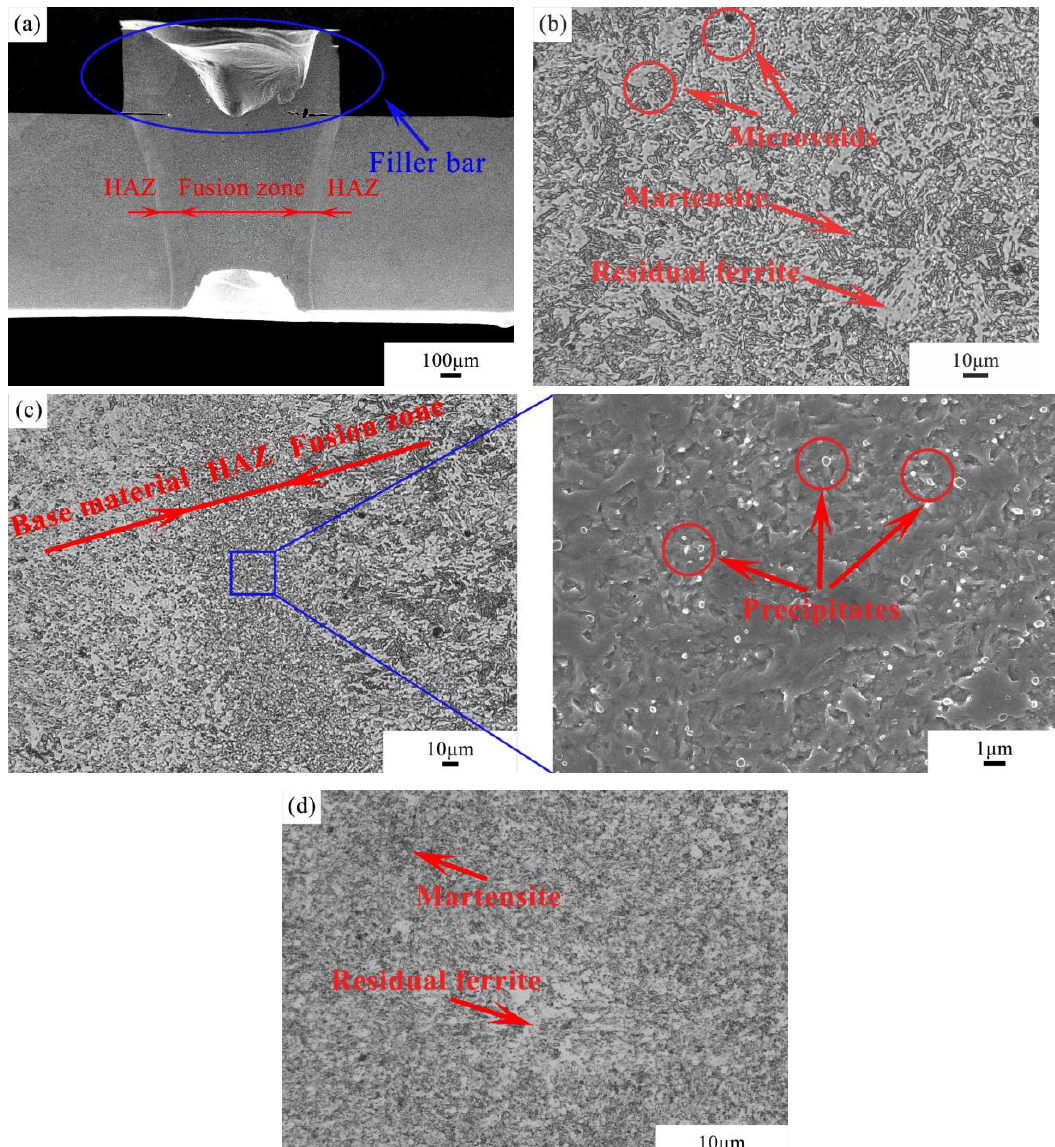
Figure 4. SEM morphologies and microhardness of the weld seam with the filler material ( P = 2500 W, t = 4 ms): ( a ) morphology of the weld seam, ( b ) weld centre, ( c ) heat-affected zone (HAZ) and ( d ) base material.